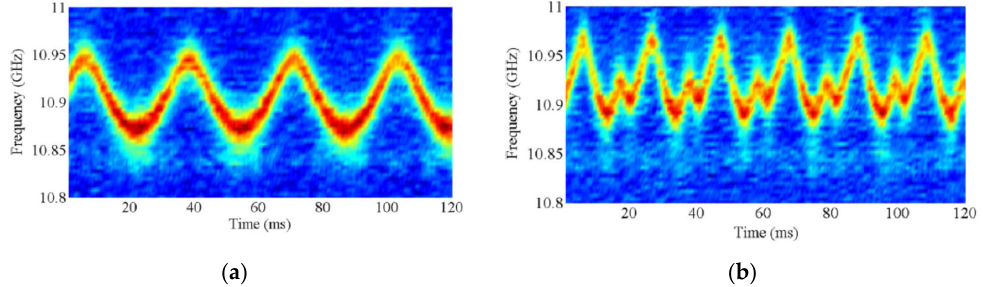
Figure 22. BGS acquired using the fast BOTDA method combined with the differential pulse-pair technique [68]. The vibrating fiber was excited at a frequency of ( a ) 33.3 Hz or ( b ) 50 Hz.